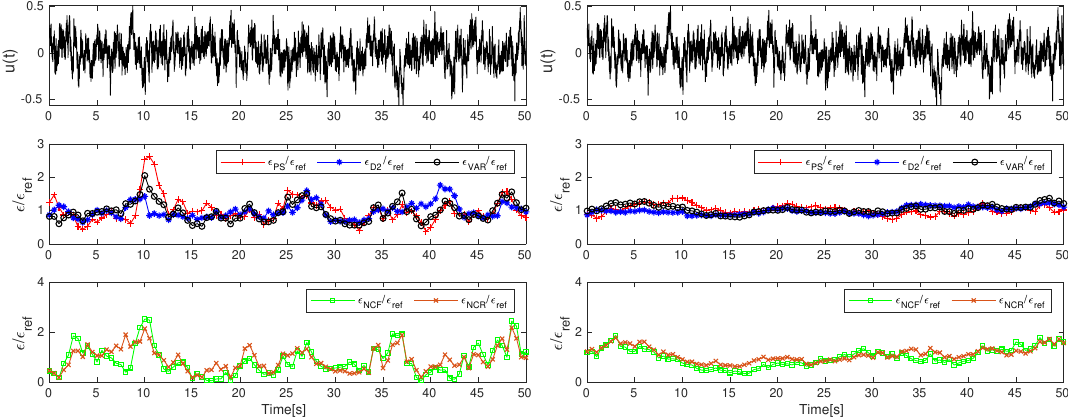
Figure 3. Top plots: Part of an artificial signal, middle plots: EDR estimates from the power spectrum (cid:101) PS , Equation (6), structure function (cid:101) SF , Equation (7) and number of crossings scaling in the inertial range (cid:101) NCF , Equation (9), bottom plots: EDR estimates from the iterative method based on the velocity variance (cid:101) VAR , Equation (10) and the number of zero-crossings per unit length, Equation (12). Left column: averaging window T ch /4, right column: averaging window T ch